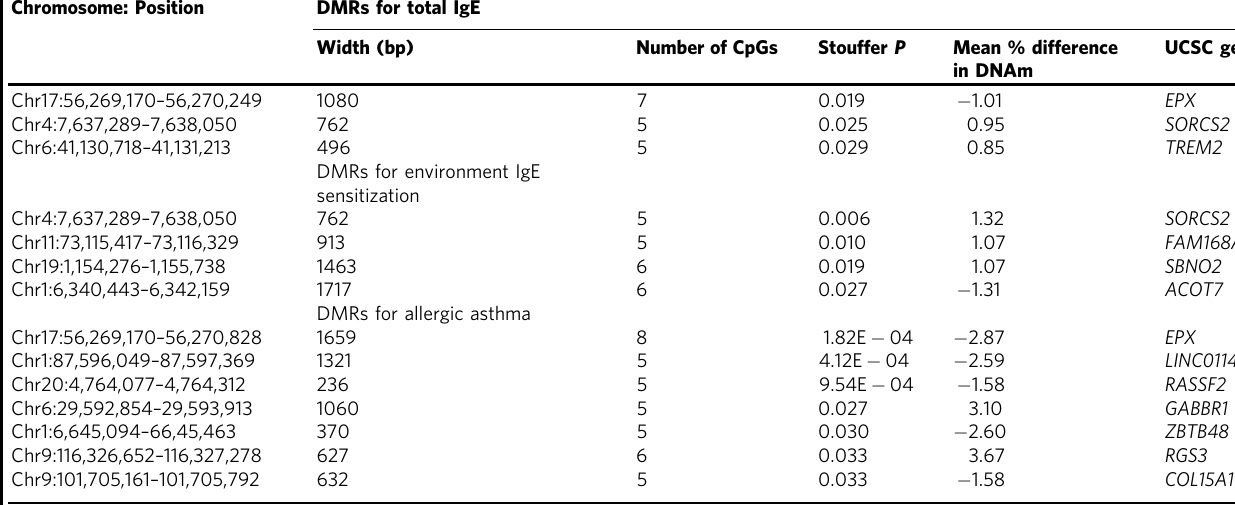
DMRs differentially methylated regions, IgE immunoglobulin E, DNAm DNA